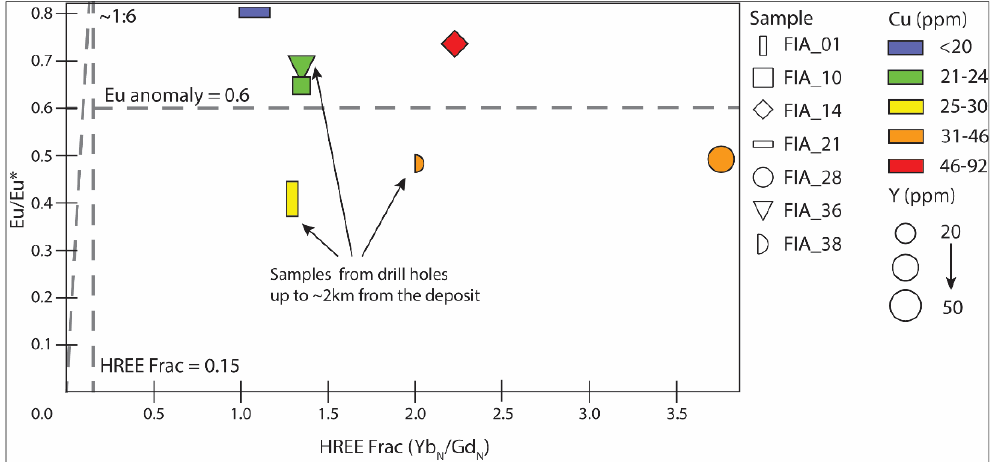
Figure 8. Whole-rock geochemical plot of HREE fractionation content vs. Eu/Eu* for samples used in this study. The shape is indicative of the samples; the colour is indicative of the Cu content and size of Y content.